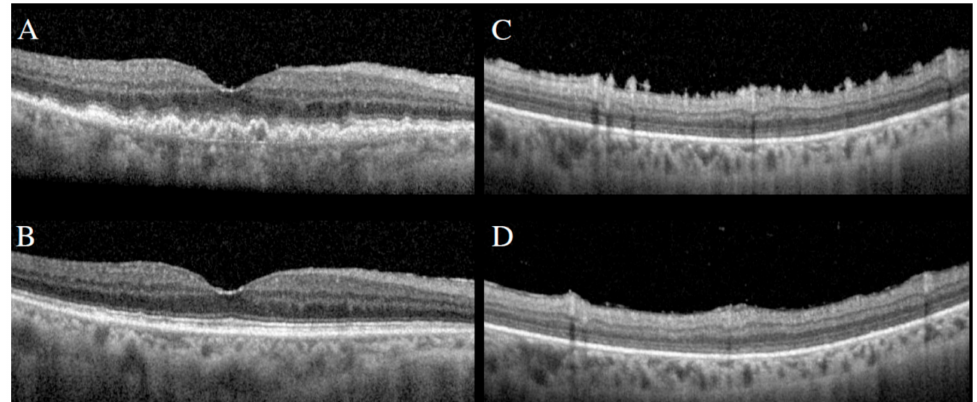
Figure 10. SD-OCT demonstrating large sub-RPE infiltrates ( A ) and preretinal/inner retinal spike-like lesions ( C ). Following intravitreal methotrexate, resolution of sub-RPE infiltrates ( B ) and spike-like lesions ( D